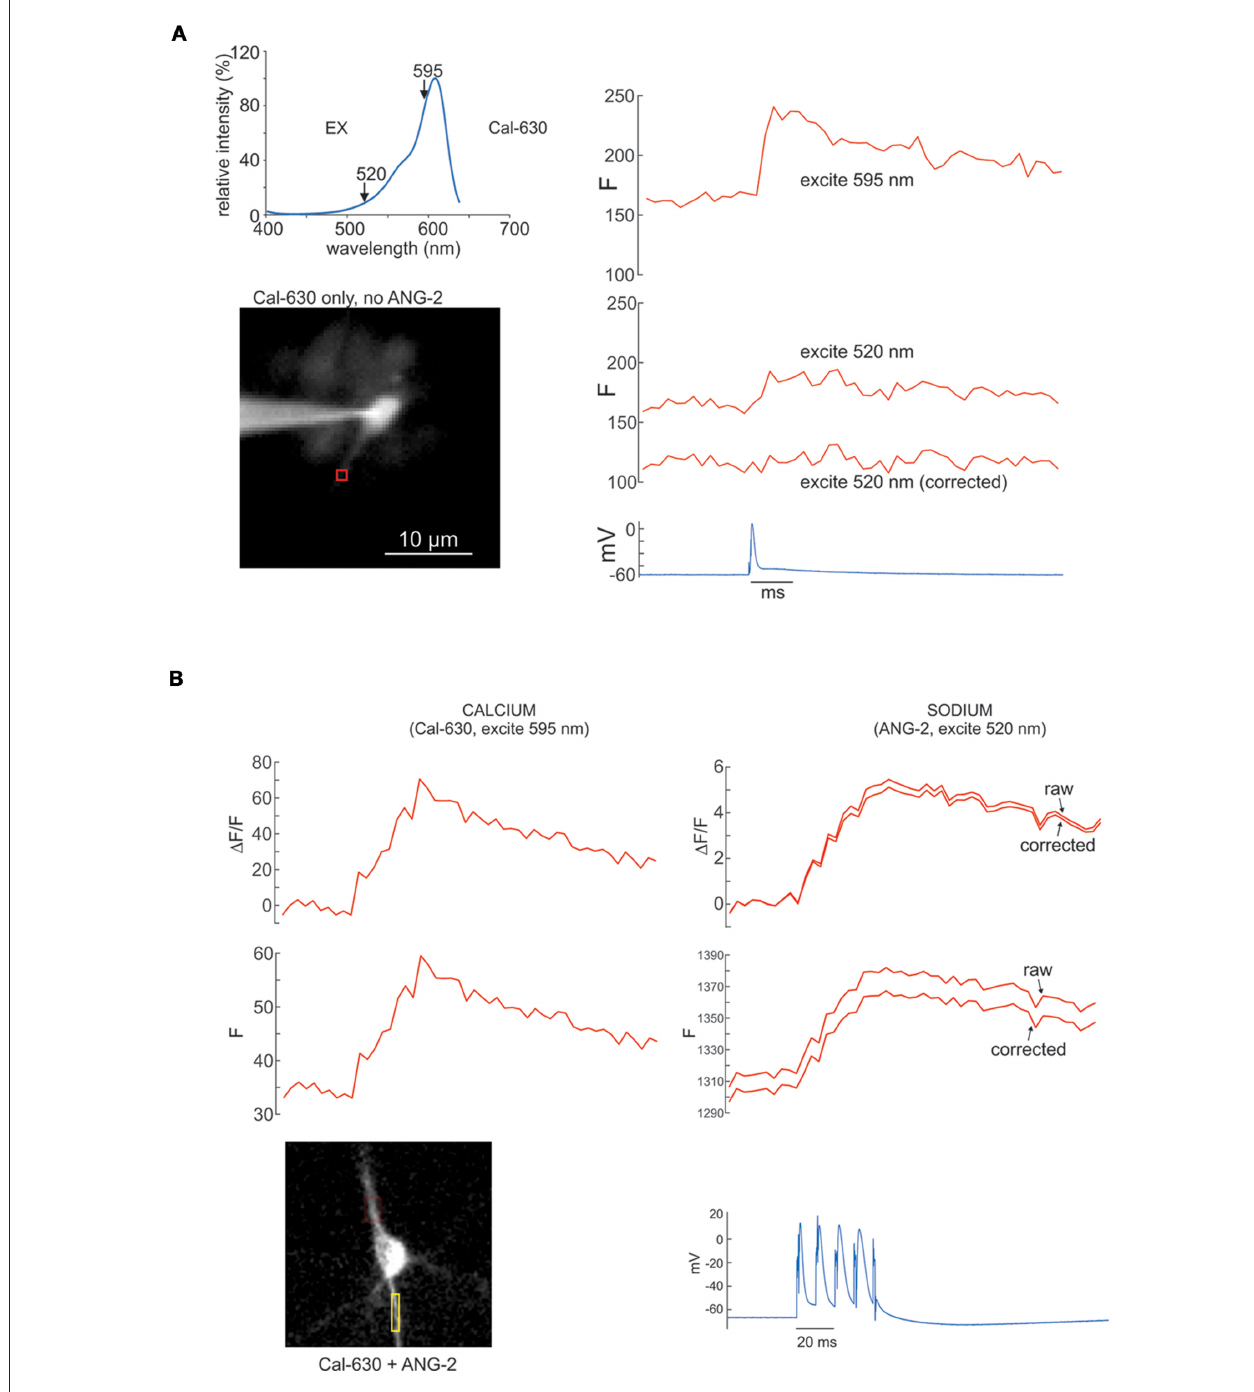
FIGURE 8 | Sodium and calcium signals from APs measured with ANG-2 (sodium) and Cal-630 (calcium) with corrections for Cal-630 excitation by ANG-2 excitation light at 520 nm. ( A , top left) Excitation spectrum of Cal-630. Note that this indicator is strongly excited at 595 nm but there is still some excitation at 520 nm. ( A , right) Fluorescence responses from a dendritic ROI of a pyramidal neuron filled with 100 µ M Cal-630 when stimulated with a single AP. The response at 595 nm is strong but there is still a signal when excited at 520 nm. The “corrected” trace, which shows no signal, was obtained when 29% of the 595 nm signal was subtracted from the 520 nm trace. ( B , left) ∆ F/F and F signals from the axon of a pyramidal neuron in response to four intrasomatically evoked APs. The cell was filled with 200 µ M ANG-2 and 100 µ M Cal-630, but the fluorescence only comes from the calcium indicator since exciting at 595 nm is outside the excitation band of ANG-2. ( B , right) Similar responses to the same four APs when the cell was excited at 520 nm. The “raw” traces are the direct fluorescence signals. The “corrected” traces have the contribution of Cal-630 to the signal removed as shown in (A) .